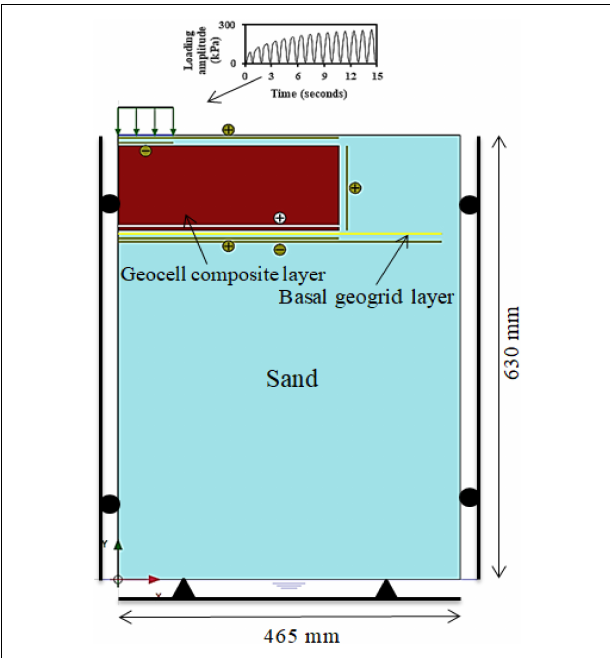
FIGURE 10 | Numerical model of the geocell reinforced subgrade with a basal geogrid layer.